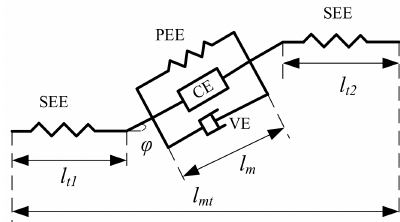
Figure A1. Hill muscle